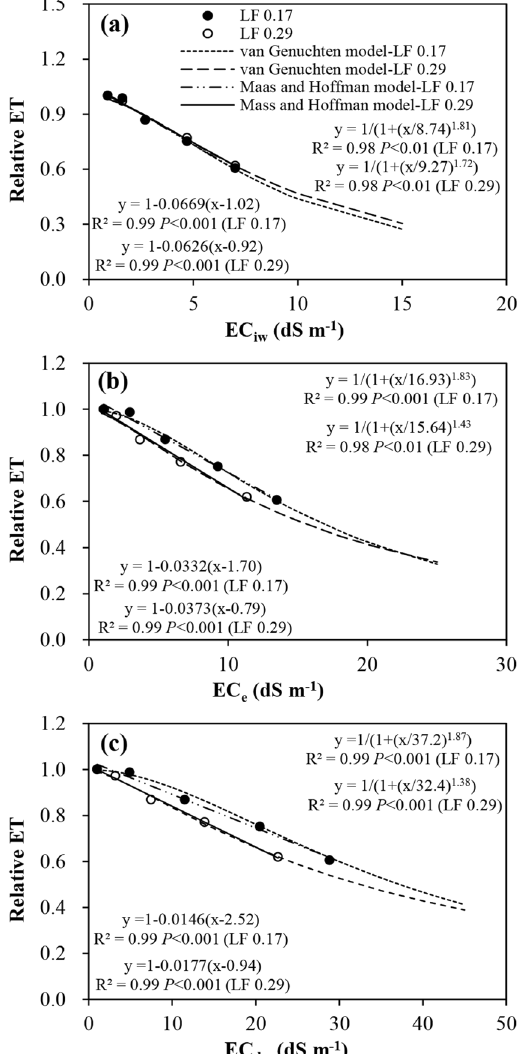
Figure 6. Relative evapotranspiration (ET) as a function of irrigation water salinity (EC iw ) ( a ), electrical conductivity of soil saturated paste extract (EC e ) ( b ), and drainage water salinity (EC dw ) ( c ) for Maas and Hoffman and van Genuchten salinity response models, respectively, under two leaching fractions